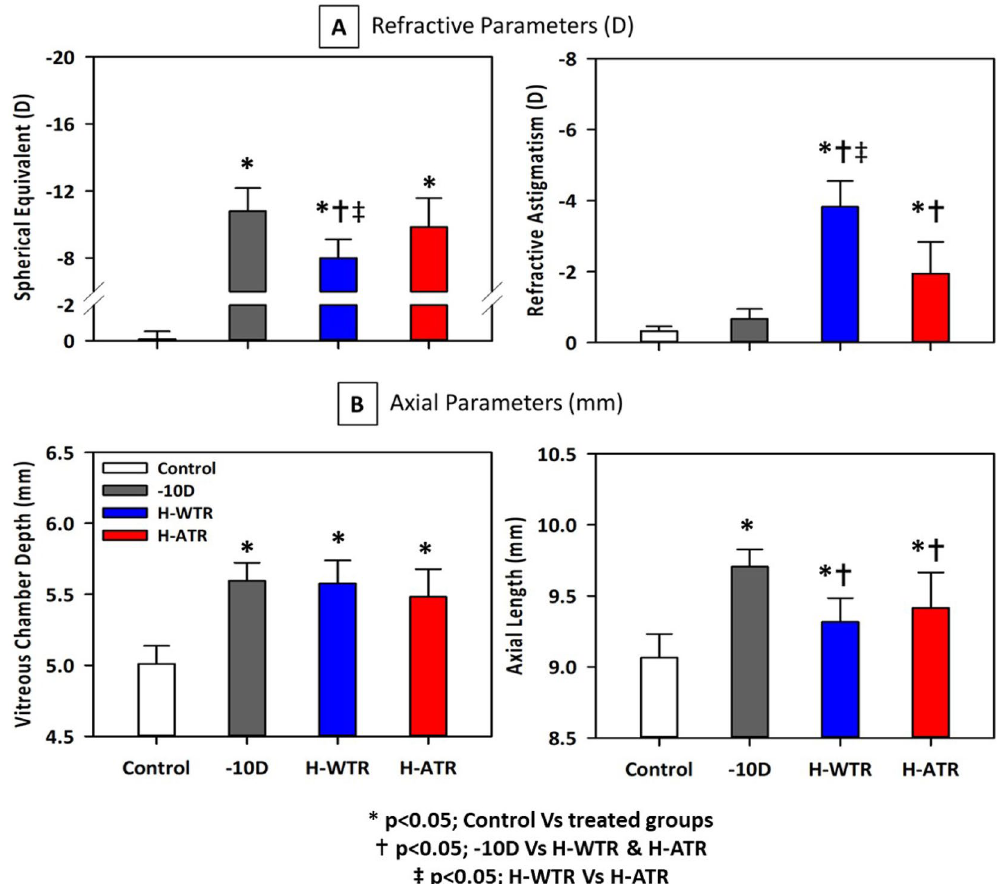
Figure 1. Effect of visual manipulations on refractive ( a ) and axial ( b ) parameters. Comparisons of ( a ) refractive (spherical equivalent and refractive astigmatism) and ( b ) axial (vitreous chamber depth and axial length) parameters across four groups of birds were performed using one-way ANOVA with Bonferroni’s pairwise post-hoc tests. The level of significance is indicated as follows: *p < 0.05, comparisons between normal and treated groups (− 10 D, H-WTR and H-ATR); † p < 0.05, comparisons between – 10 D and the two sphero- cylindrical lenses treated groups (H-WTR and H-ATR); ‡ p < 0.05, comparisons between two sphero-cylindrical lenses treated groups (H-WTR and H-ATR). When compared to normal group, all three treatment groups were found to have significantly higher myopic errors, increased vitreous chamber depths and axial lengths. H-WTR group developed less myopic error but more refractive astigmatism when compared to – 10 D and H-ATR